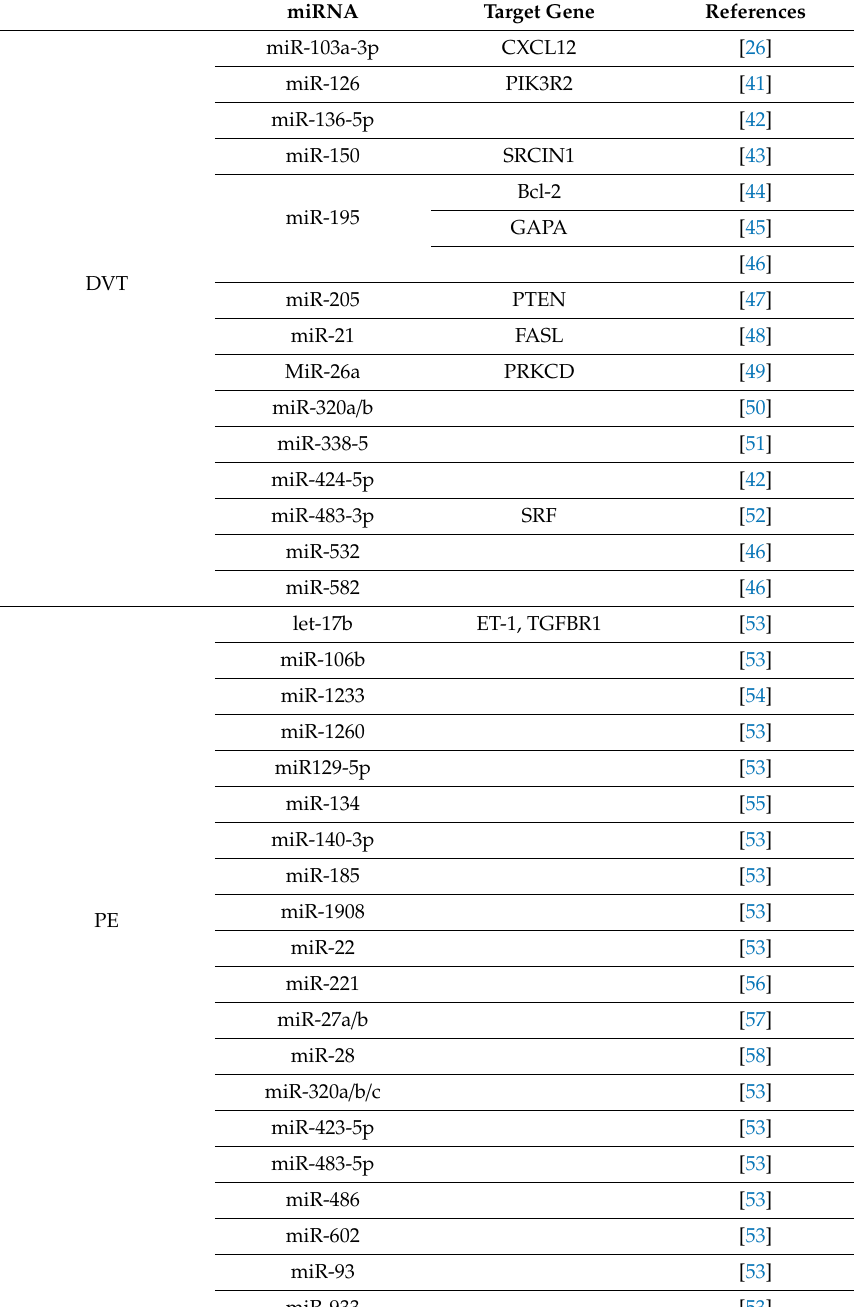
Table 2. MiRNAs Associated with Di ff erent Types of